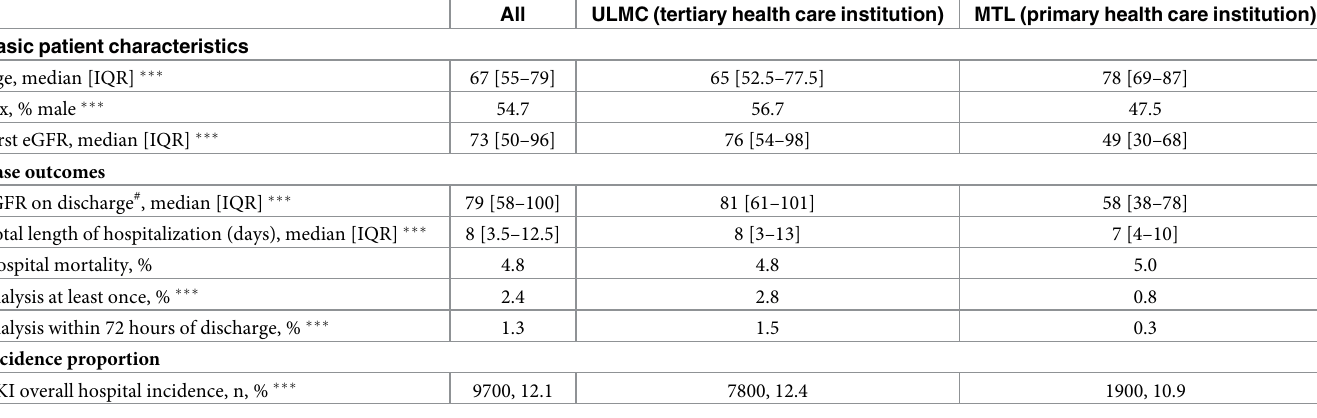
Table 2. Study cohort and a comparison of the incidence proportion, the basic patient characteristics, and the case outcomes between ULMC and MTL. All ULMC (tertiary health care